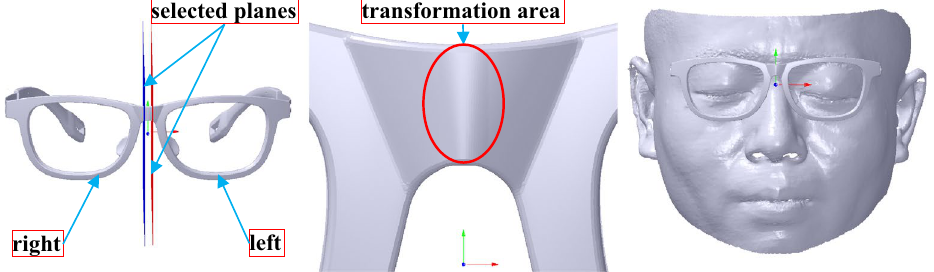
Figure 11. The frame translation. From left to right: the frame translation based on selected planes marked with blue and red planes, the frame translation result, the frame translation result showing the face.